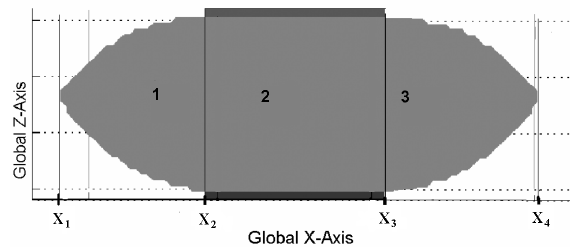
Figure 14: The workspace area of Gantry-Tau machine in the XZ-plane when it is reconfigured to work in both right- and left-handed assembly modes.